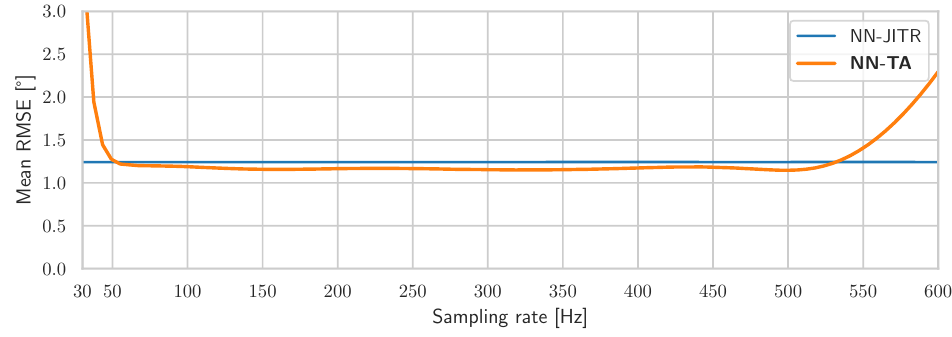
Figure 8. Comparison of the mean RMSE of NN-JITR and NN-TA over an extended sampling frequency range. NN-TA performs slightly better within the trained frequency range but fails outside. Due to just-in-time resampling, NN-JITR shows stable performance over the entire extended frequency range. Bold font indicates the chosen final configuration.